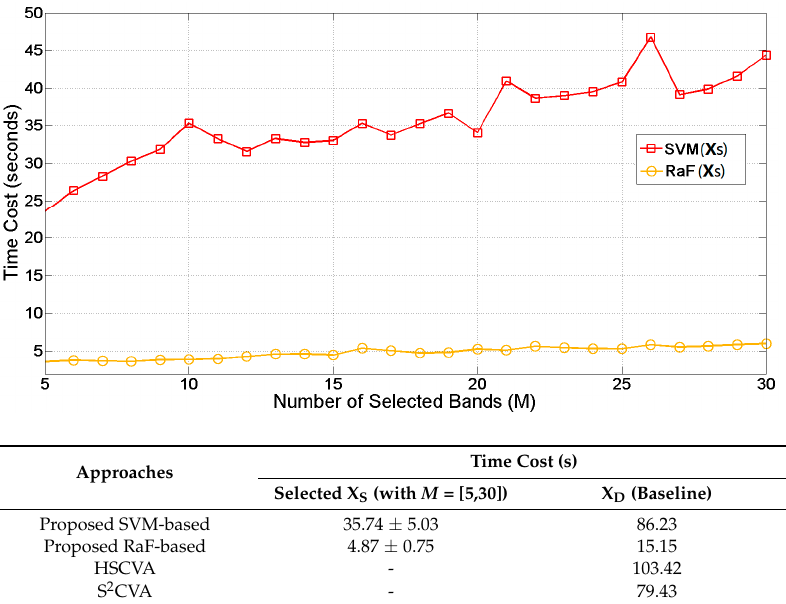
Figure 12. Computational cost in two proposed supervised CD approaches based on different X S (mean with standard deviation), in comparison with the ones based on X D and two reference methods. Note that the time cost for band selection is included in the proposed approaches (Yancheng dataset).